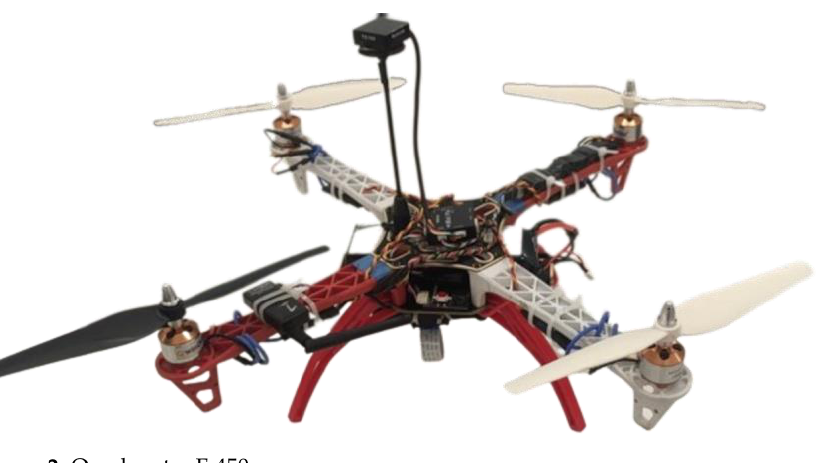
Figure 1. Vision system proposed for the TGBOA algorithm.